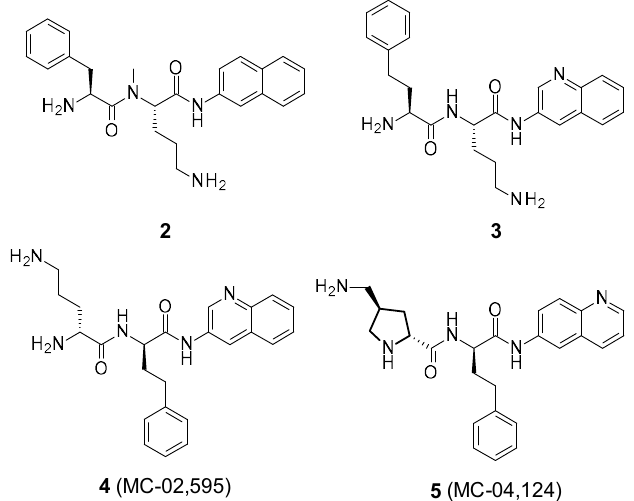
Figure 2. Structure of PA βN